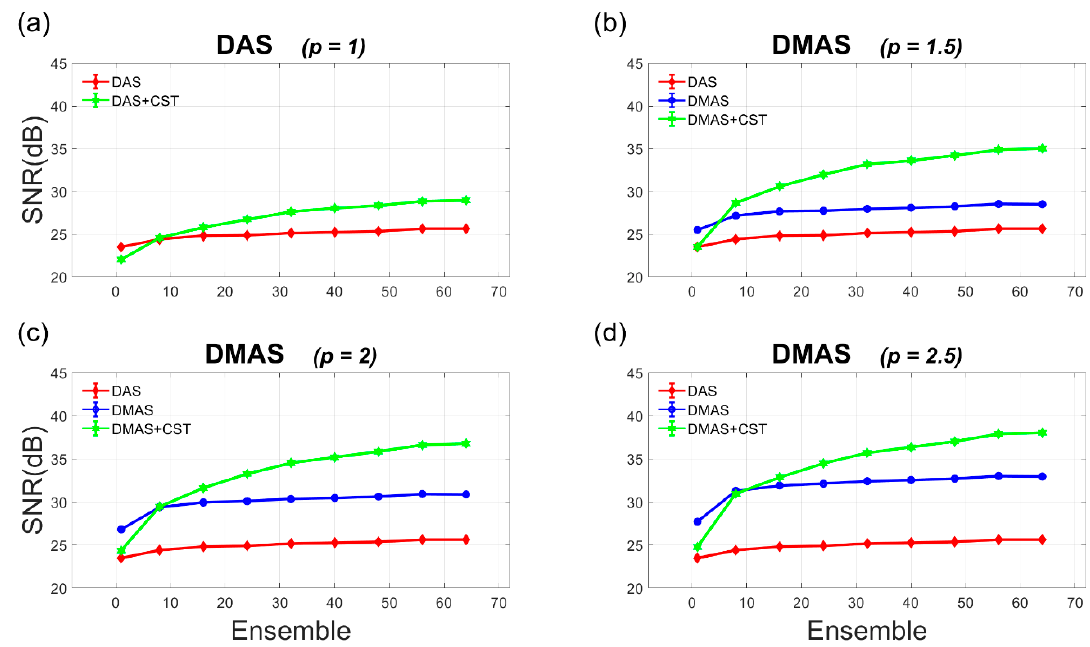
Figure 10. Quantitative analysis of Doppler SNR in the experiments as a function of ensemble number for ( a ) DAS beamforming and ( b – d ) DMAS beamforming with the p value of 1.5, 2.0, and 2.5, respectively.